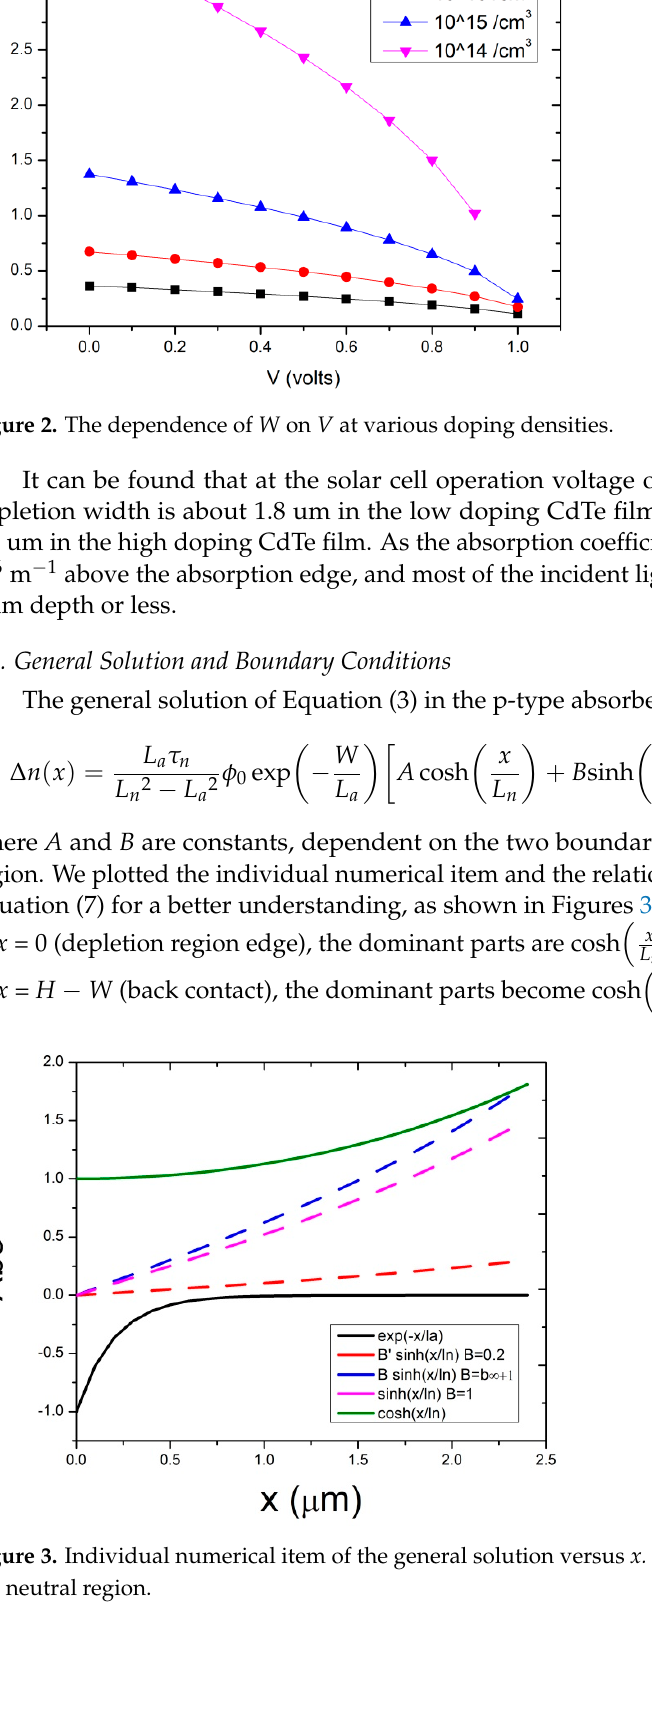
Figure 4. The relationship between ∆ n and x of the general solution . x is defined as any position in the neutral region. The unit of ∆ n is cm − 3 . (a) At x = 0 (depletion region edge), ∆ n = 0. The electric field in the depletion region swipes out all the photo-electrons swiftly. (b) At x = H-W (back contact), ∆ n = 0. For CdTe cell with p-type ohmic contact, no electron reflector or surface field at the back, we have